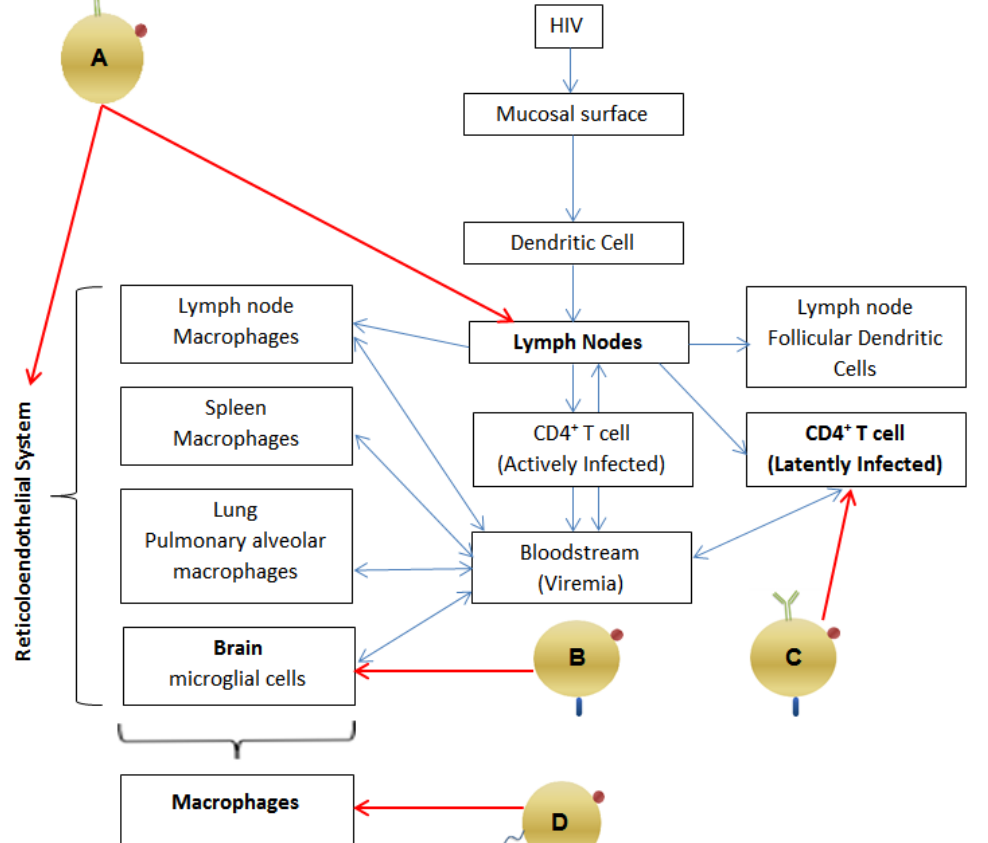
Figure 1. Possible reservoirs of HIV and the potential role of nanotechnology. HIV establishes anatomical reservoirs in lymphoid tissue, the reticuloendothelial system and other sites not shown here. Antiretroviral drugs do not penetrate these sites adequately. Macrophages and latently infected CD4 + T cells constitute cellular reservoirs, because antiretroviral drugs do not achieve satisfactory intracellular concentration within macrophages and antiretrovirals are ineffective against latent virus, respectively [13,14,16–18]. Potential means of using nanotechnology to combat viral reservoirs are shown (the relevant sections in the text are indicated): ( A ) Targeted delivery of antiretroviral drugs to the reticuloendothelial system, including lymphatic tissues (Section 8); ( B ) Targeting the brain (Section 9); ( C ) Targeting latently infected CD4 + T cells (Section 10); ( D ) Achieving optimal intracellular concentration of antiretroviral drugs within macrophages (the work of Amiji and colleagues is described in the section on nanocarriers, Section